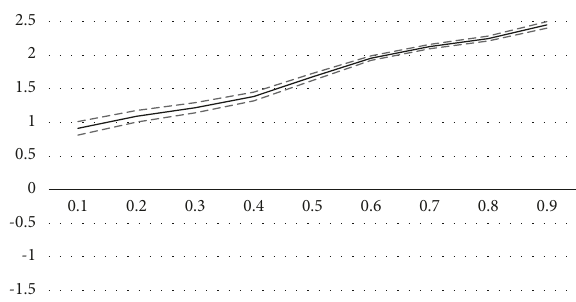
Figure 3: Phase-EPU quantile regression result.